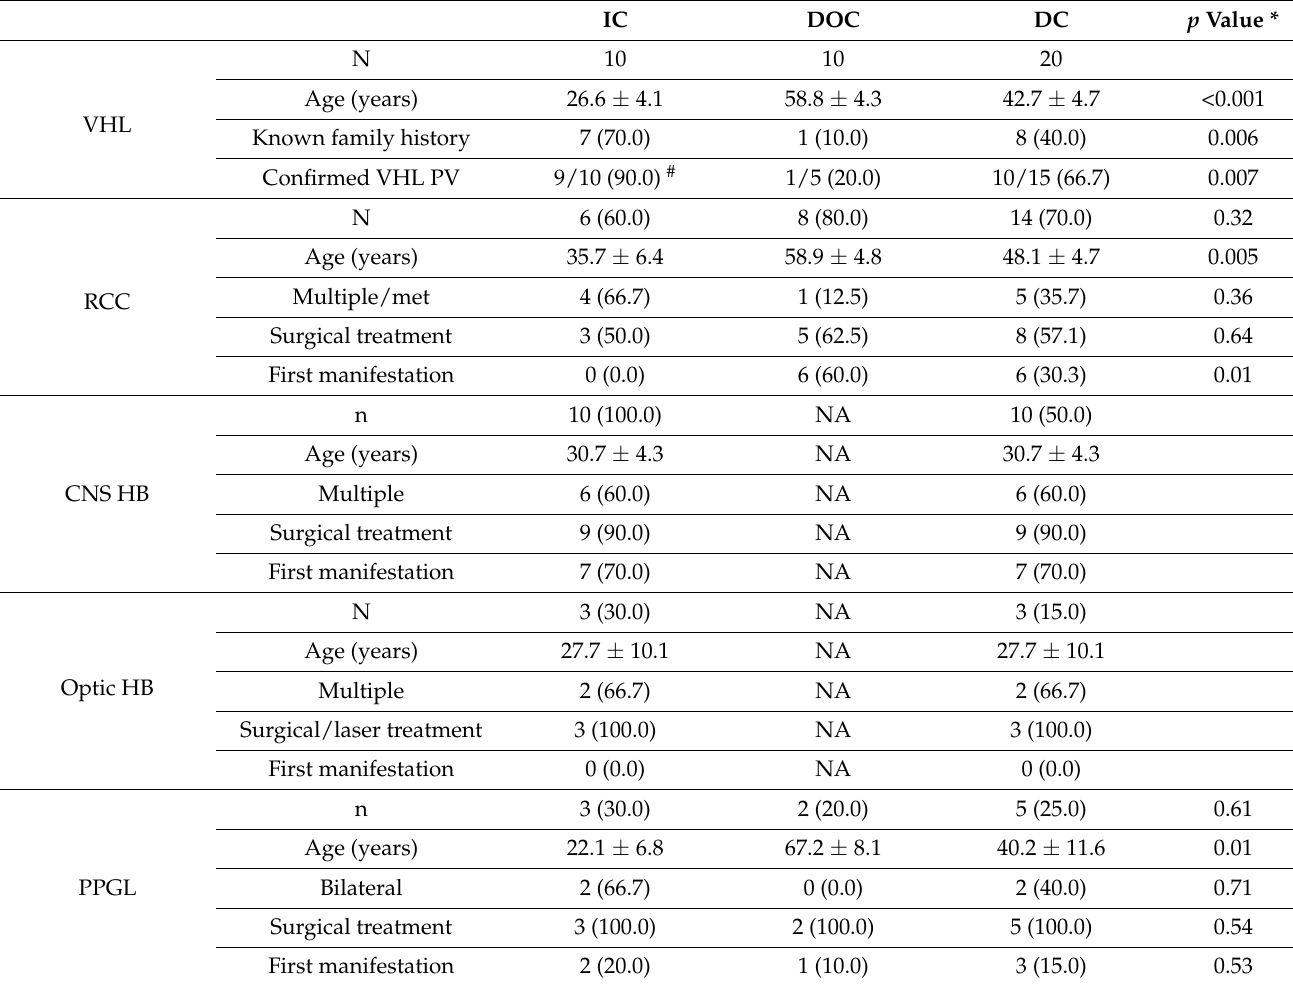
Table 4. Comparison of VHL manifestations in patients with a concurrent diagnosis of PNET based on the IC vs.